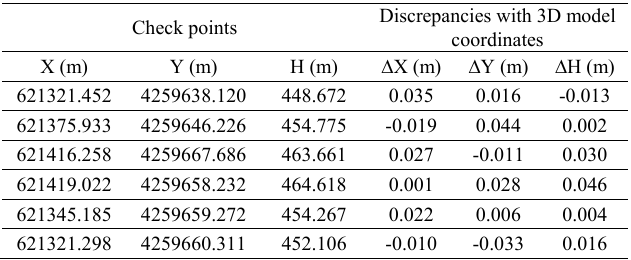
Table 7. Geo-referencing errors.